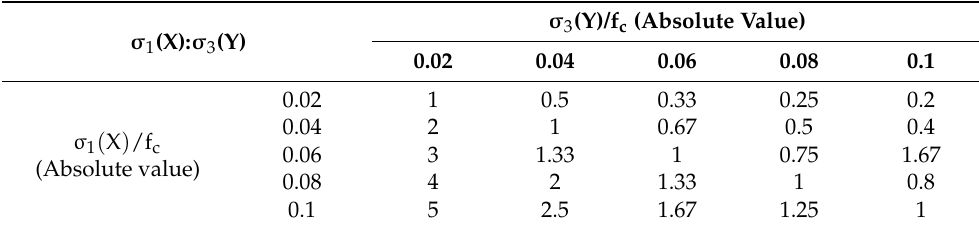
Table 4. Tensile stress ratios in the X- and Y-axis directions.